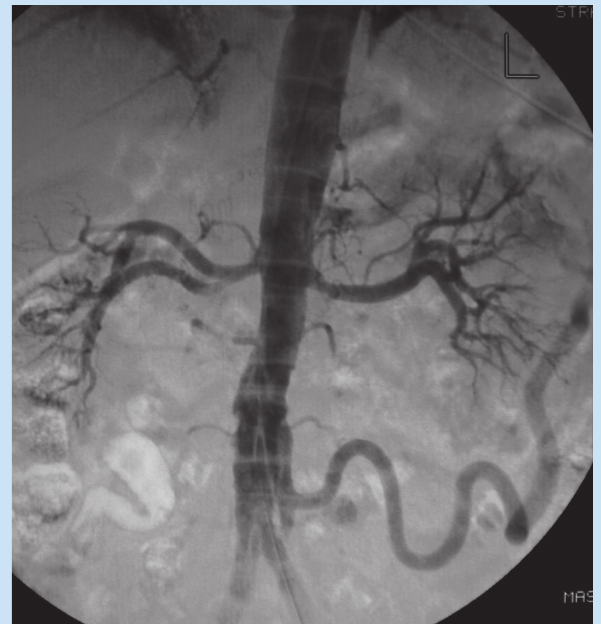
Fig. 1a. Digital subtraction arteriogram shows prograde filling of the abdomi - nal aorta, bilateral renal arteries and inferior mesenteric artery. There is no filling of the celiac axis or superior mesenteric artery, implying stenosis or cut-off of these vessels. A meandering artery is visible.